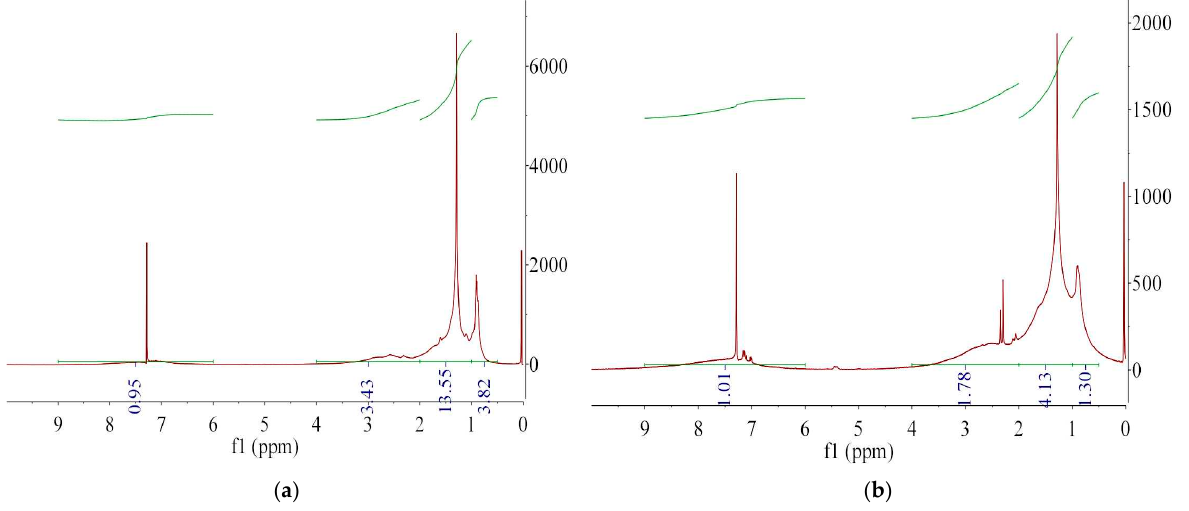
Figure 3. The molecular structures of the extracted asphaltenes and the base asphalt characterized by NMR: ( a ) Hydrogen NMR spectrum of base asphalt; ( b ) NMR spectrum of the obtained asphaltenes. The hydrogen content was integrated using MestReNova software to calculate the proportion of hydrogen atoms in different categories and the structural